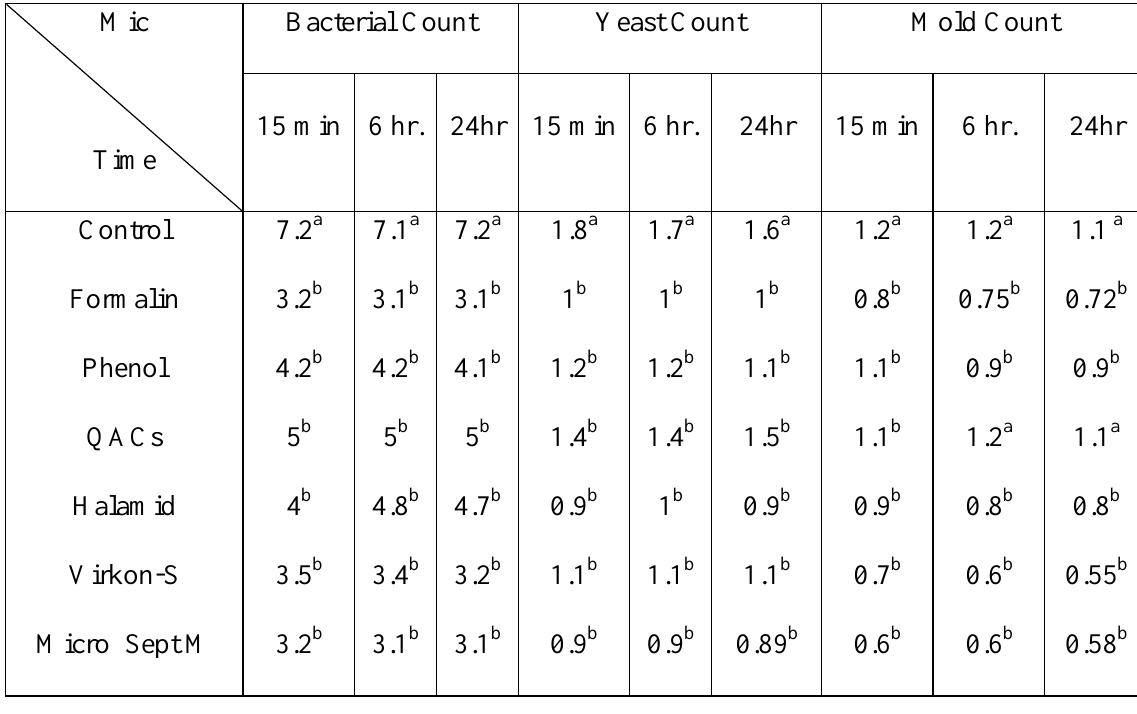
Table 4: The effect of cold fogging and contact time on total aerobic bacteria, yeast, and molds. Mic Bacterial Count Yeast Count Mold Count